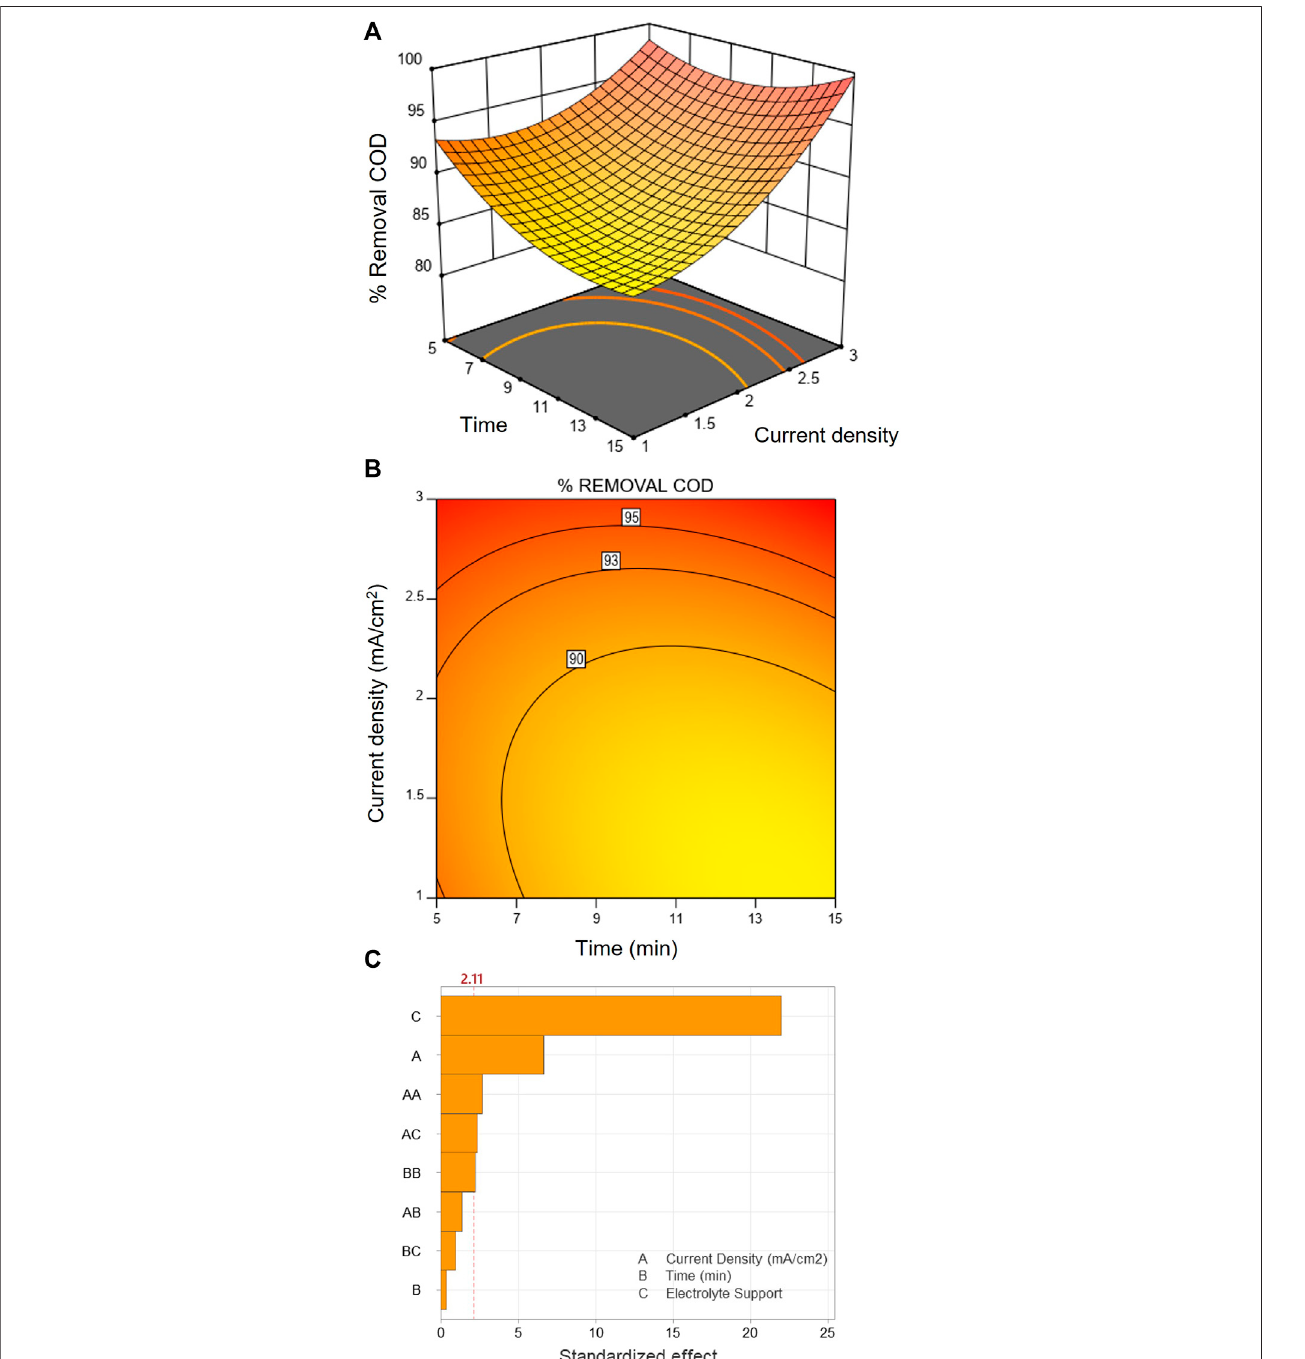
FIGURE 3 | (A) 3D Response Surface of the effect of current density (mA/cm 2 ), time (min) and electrolyte support (sea salt 0.005 M). (B) Contour plot of t (min) versus density (mA/cm 2 ). (C) Pareto plots of standardized effects, all on the COD removal ef fi ciency.